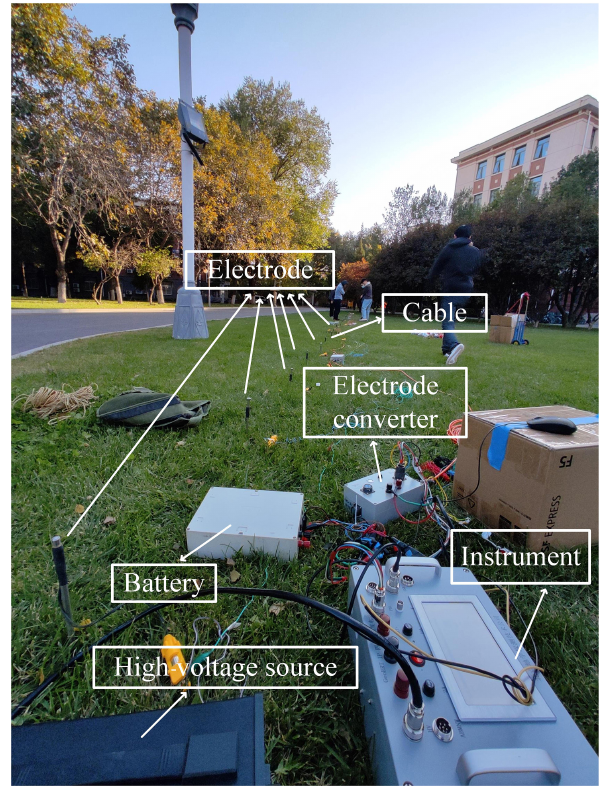
Figure 10. Photo of the scene of the campus